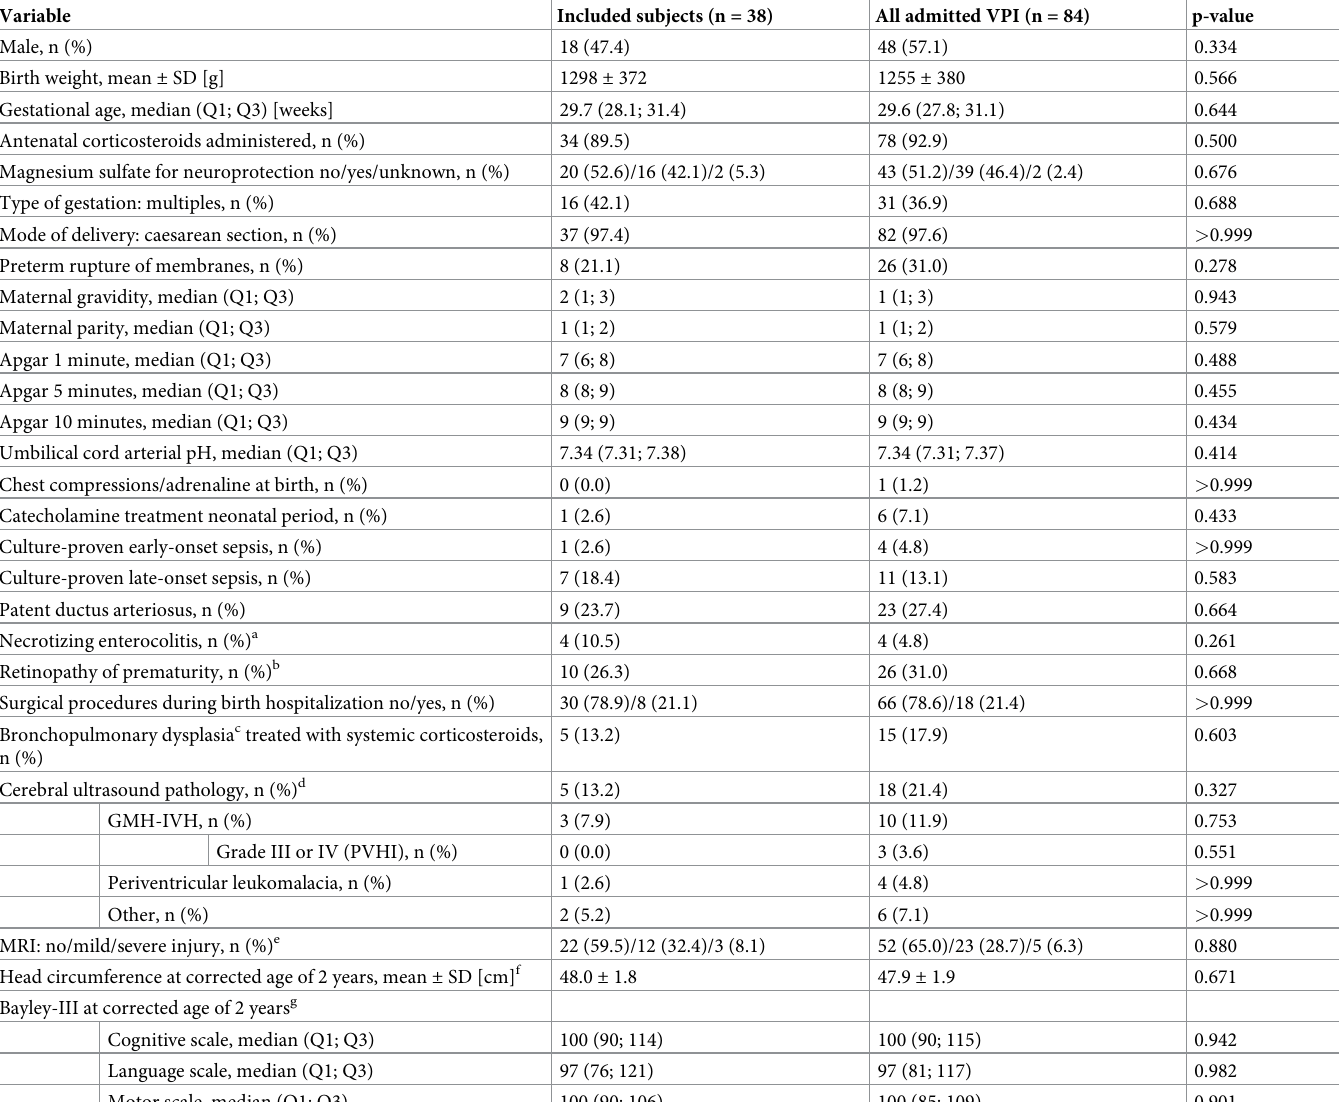
Table 1. Characteristics of included subjects of the study cohort and all very preterm infants (VPI) admitted to our unit during the study